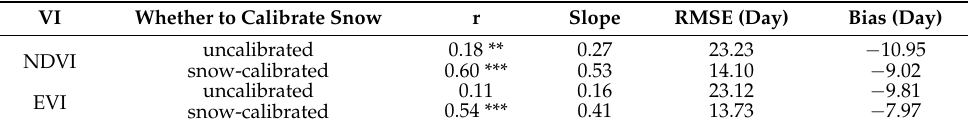
Table 2. Comparison between ground-observed GUD and GUDs extracted by CCR max from two conventional VIs (NDVI and EVI) with and without snow